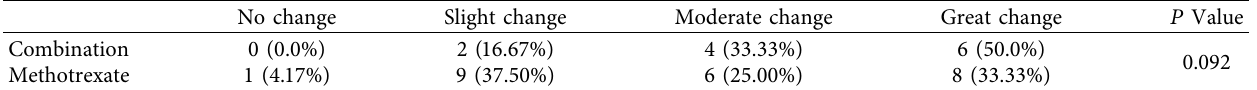
Table 5: The change in photographic assessment at the end of follow-up in two